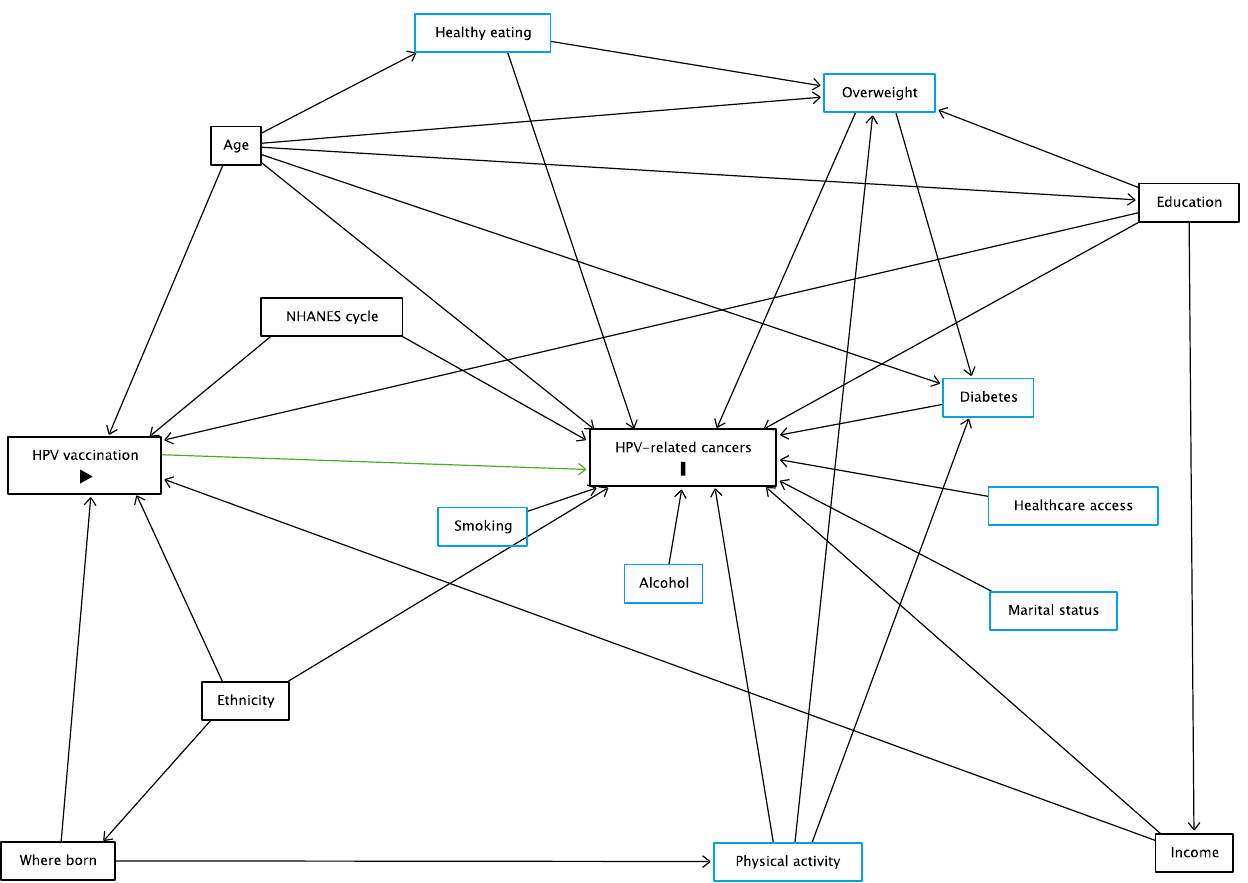
Figure 2. Directed acyclic graph examining the association of human papillomavirus (HPV) vaccination history with HPV-related cancers. Age, ethnicity, education, household income, and whether participants were born in the U.S. or not, and National Health and Nutrition Examination Survey (NHANES) cycle are considered as confounders; adjusting for these blocks all backdoor pathways (indicated in gray boxes). Marital status, any history of consuming 4–5 alcohol drinks daily (alcohol), having smoked at least 100 cigarettes over their lifetime (smoking), self-reported diet (healthy eating), a history of being overweight, a history of diabetes, moderate or vigorous physical activity at work, and routine access to healthcare services “when sick or need advice about health” (healthcare access) are assumed to be risk factors for HPV-related cancers (shown in blue, except “HPV-related cancers”, which is the outcome). The variable in green with sign “ ” is the primary exposure variable (HPV vaccination). The variable with “ ” sign is the outcome (HPV-related cancers).